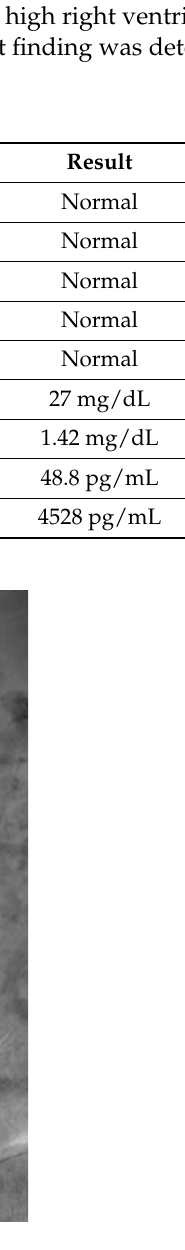
Figure 2. Chest radiograph showed engorged bilateral main pulmonary arteries and pruning of pe- ripheral pulmonary vessels. The orange and reddish lines indicate the diameter of the right (21 mm) and left (24 mm) main pulmonary artery, respectively.